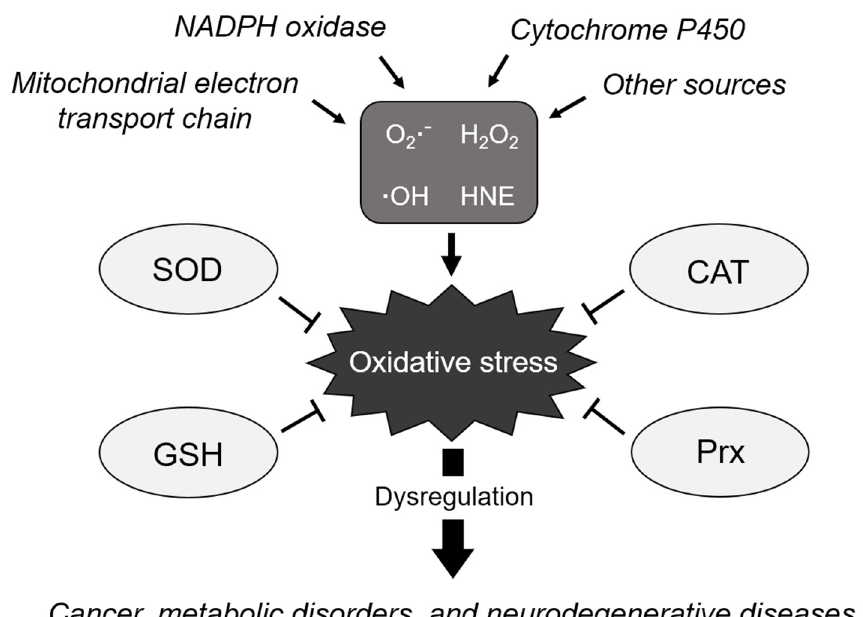
Figure 1. Schematic of the biological processes regulating cellular redox homeostasis. ROS are generated from various sources due to incomplete reduction of oxygen, causing oxidative stress. The elimination of ROS is tightly regulated by antioxidants, such as SOD, to maintain homeostasis and avoid oxidative stress. However, dysregulation of oxidative stress induces various diseases